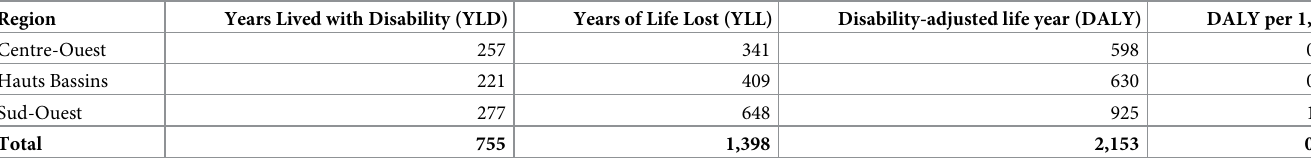
Table 3. Annual disease burden of snake envenoming in three regions of Burkina Faso (hospitalised patients only).